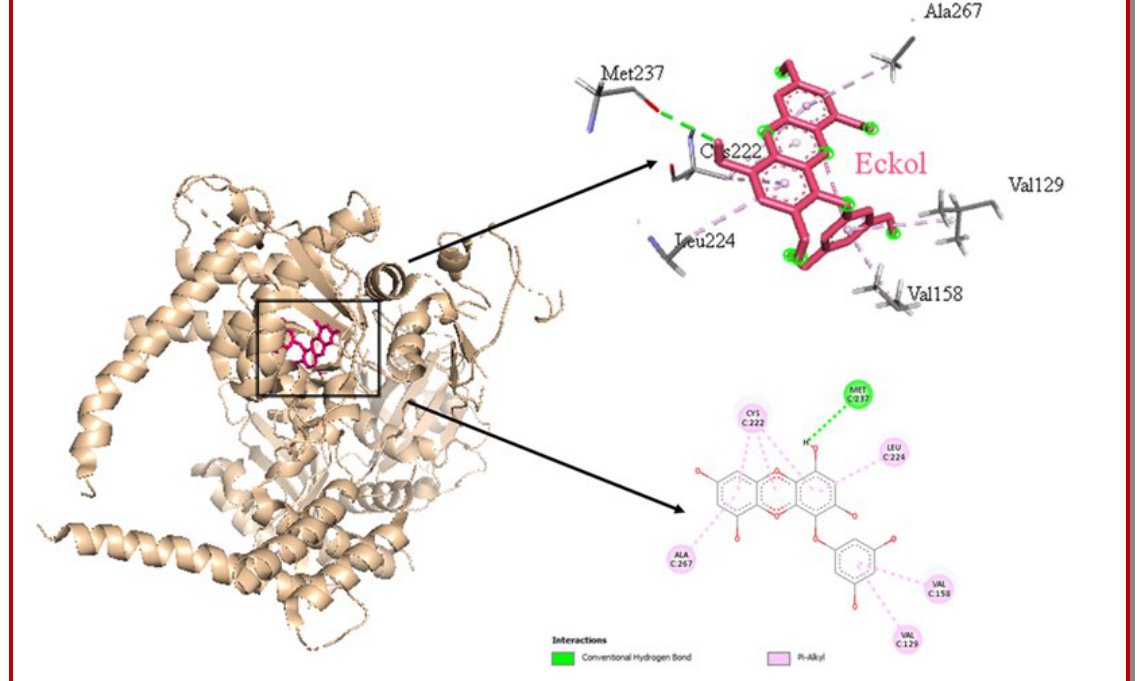
Figure 1: Binding residues and interactions of AhR with eckol